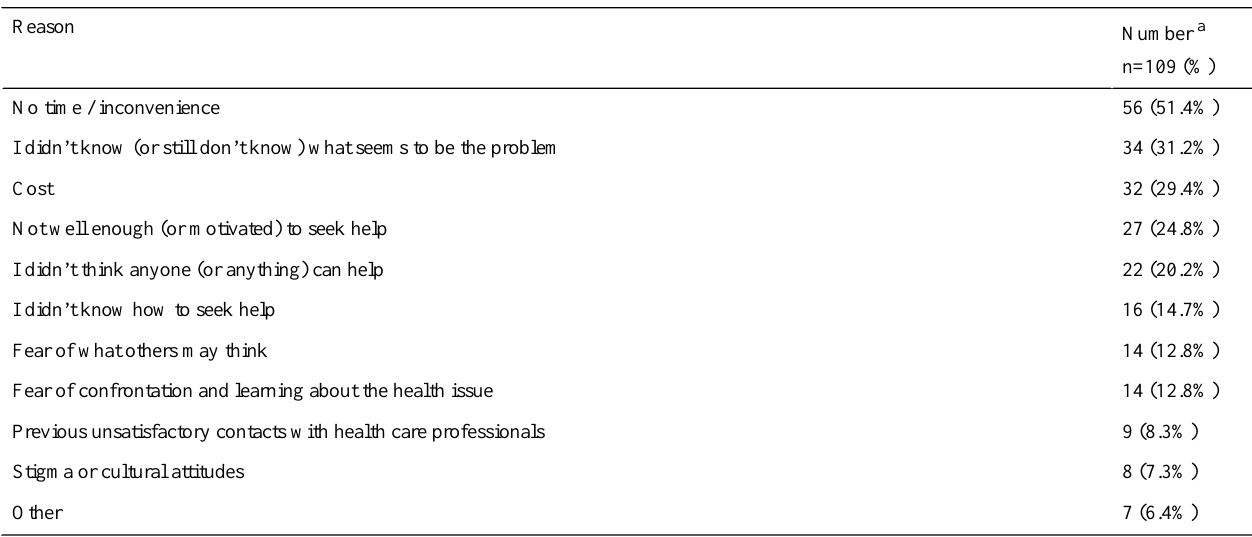
Table 4. Reasons for not seeking help for physical well-being concerns during study (n=109).